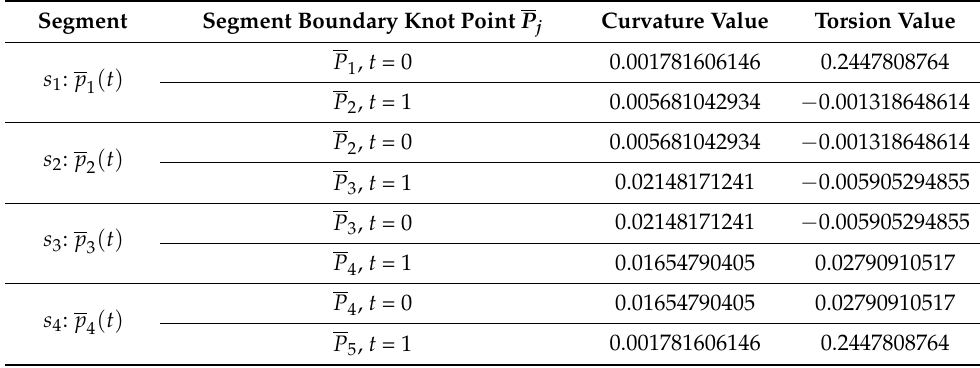
Figure 10. Closed fifth-degree Hermite spline curve of four segments. Table 3. Curvature and torsion values at boundary points of the segments.